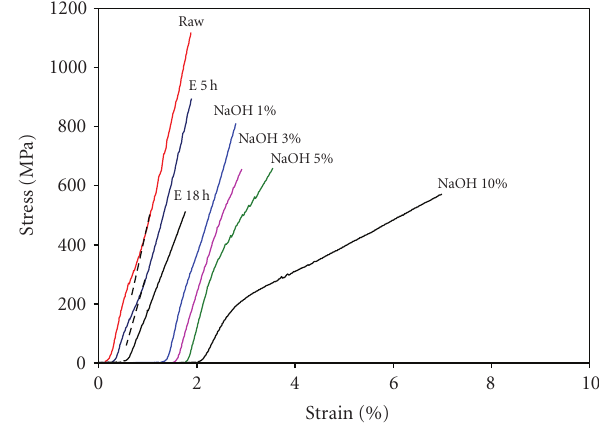
Figure 5: Comparison of stress versus strain curves of raw-, NaOH-, and Enzyme-treated elementary flax fibres under tensile loading. Shaded region corresponds to a threshold stress level bellow which fibres broke before pullout in microbonding